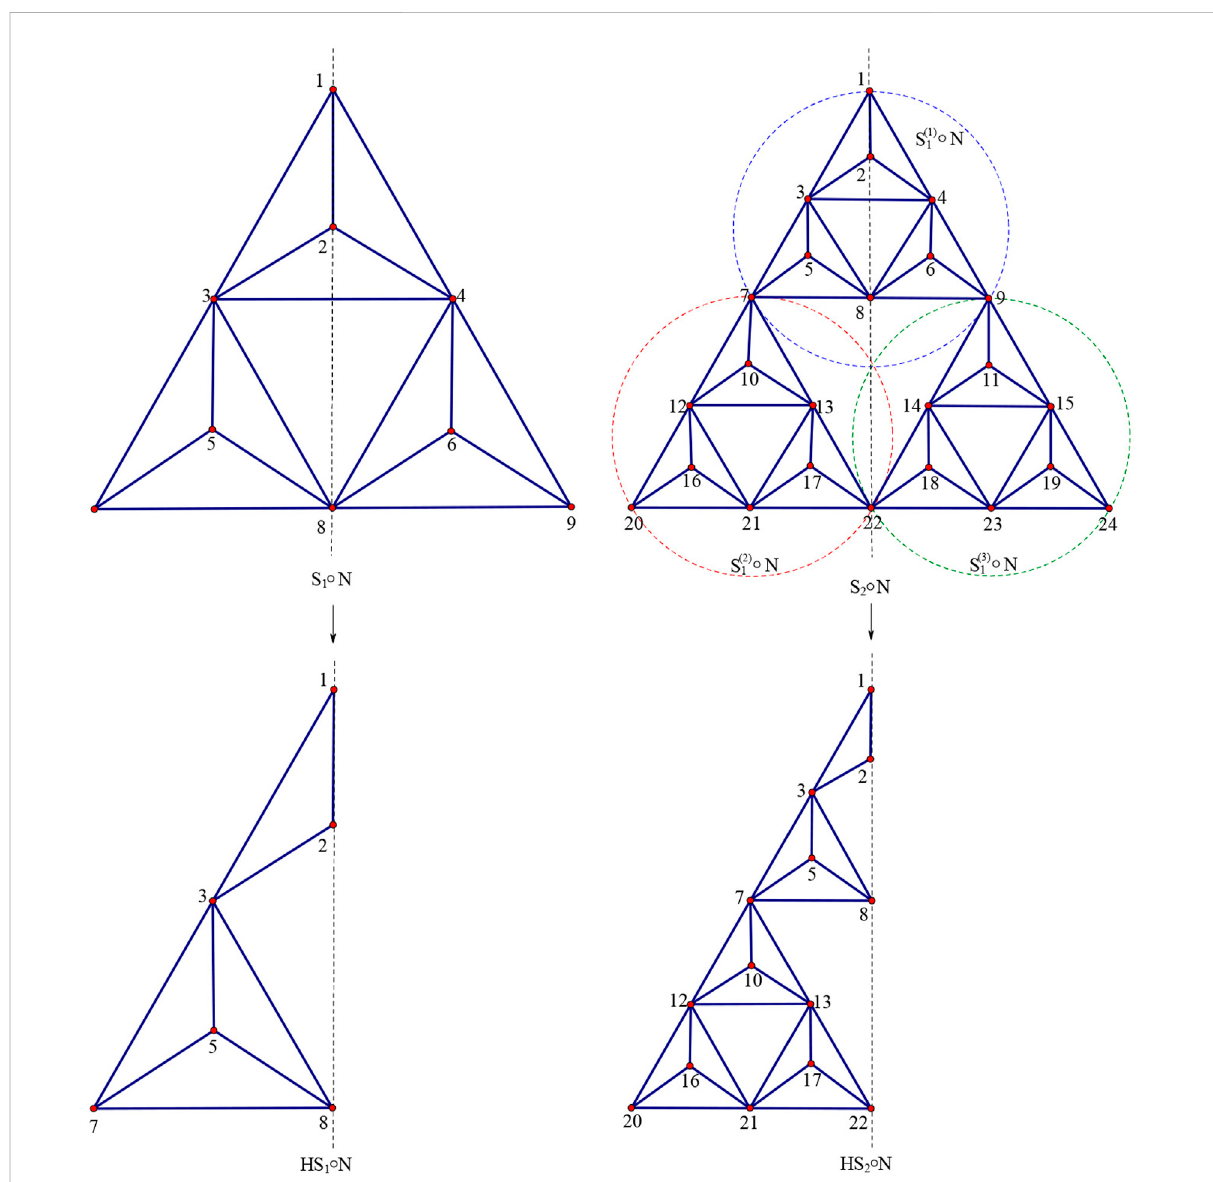
FIGURE 2 First two generations of S n ◦ N and HS n ◦ N for n = 1 and